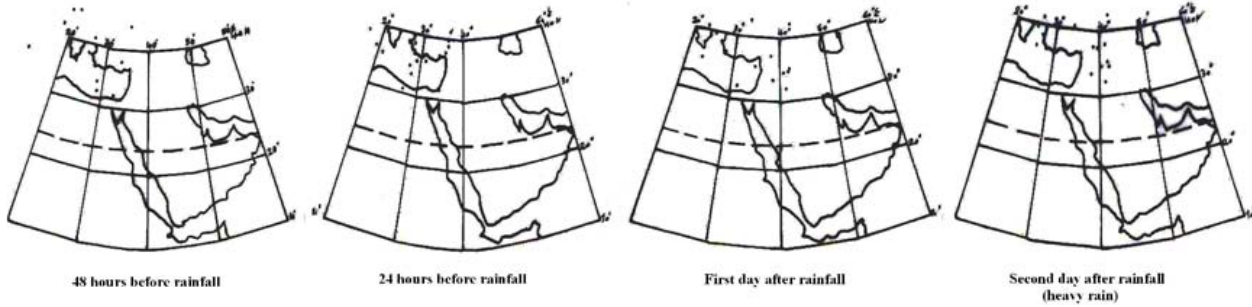
Fig. 20. The location of the 500hPa LA centers of the 20 selected floods two days before the rainfall (left pictures) and in first day and